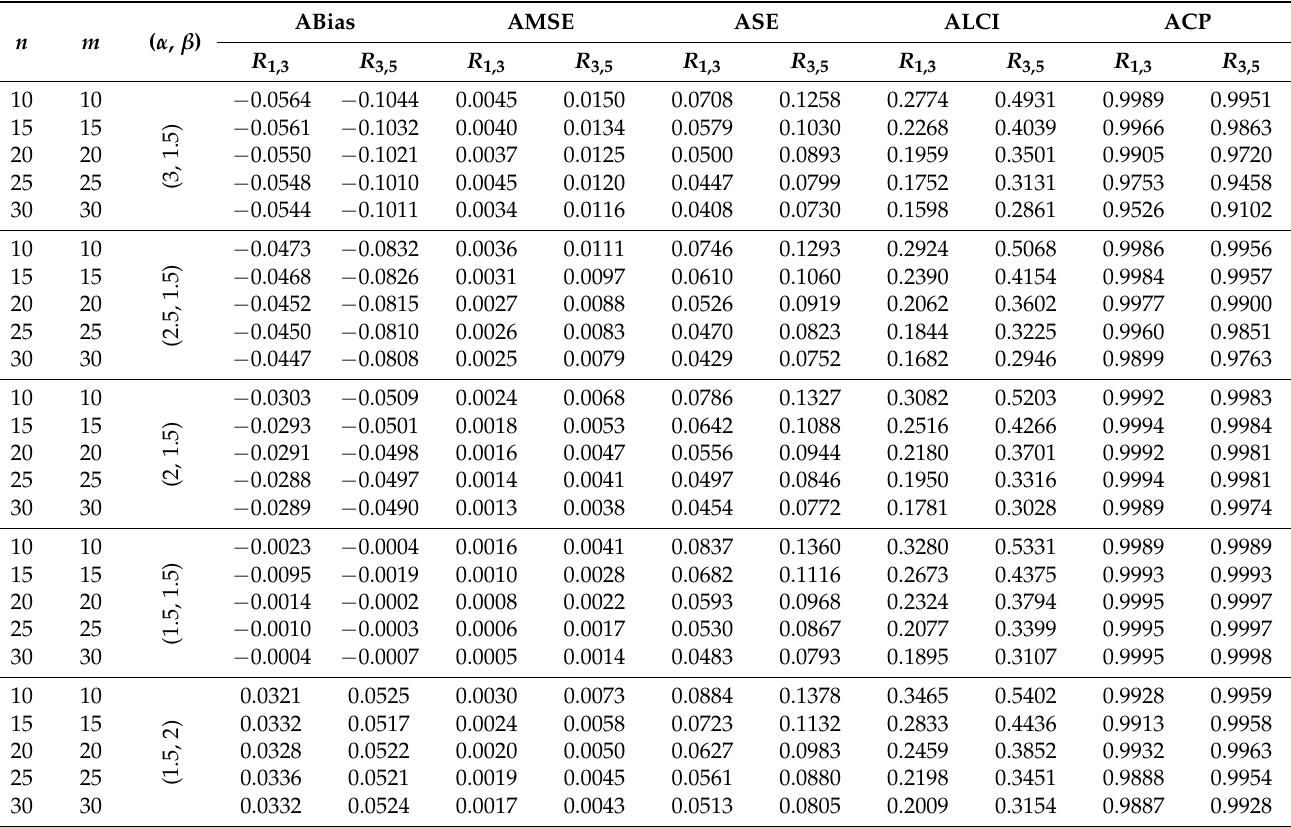
Table 2. The AveBias, AMSE, ASE, ALCI, and ACP of ˆ R s , k